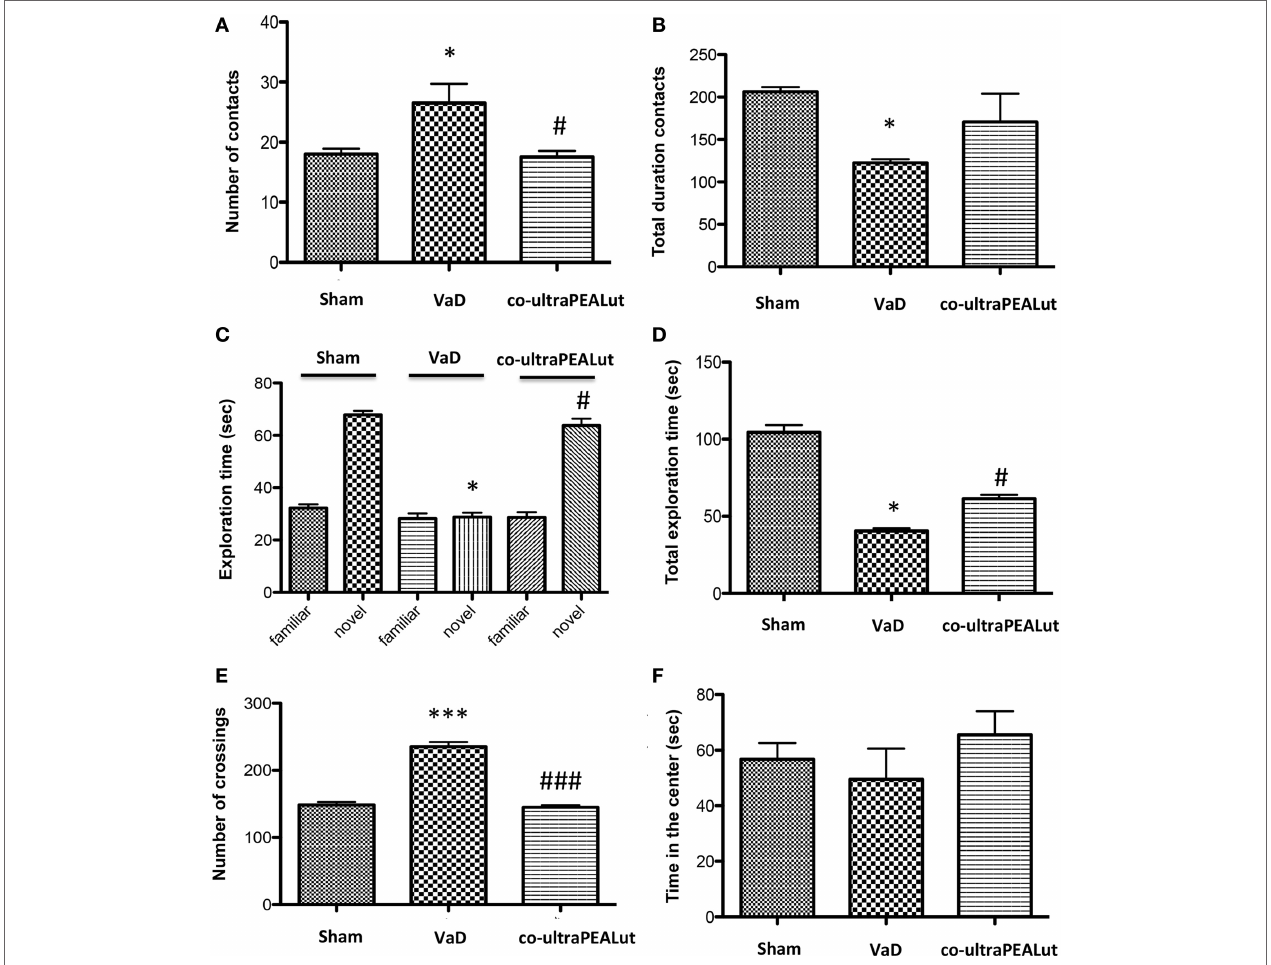
FigUre 3 | effect of co-ultraPealut on behavioral changes in vascular dementia (VaD) mice . (a,B) Effects of co-ultraPEALut treatment on Reciprocal Social Interactions. (a) The number of contacts was significantly increased in VaD mice; while number of social contacts was decreased in mice treated